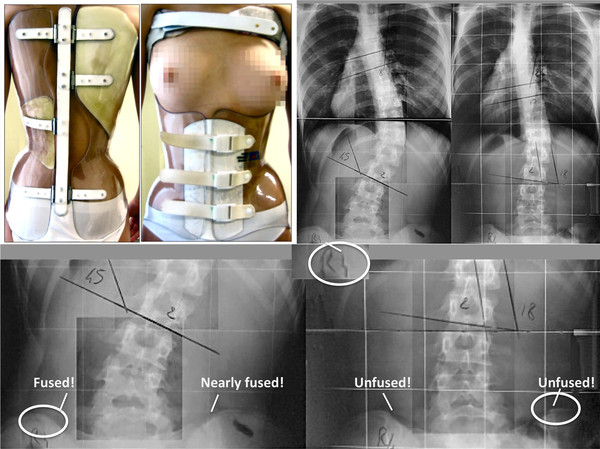
A sample of figures demonstrating that also in bracing it is not uncommon to treat mature individuals. The female patient on the upper left clearly is mature (Breast staging: Tanner 5). The x-rays as published within the same figure together with the clinical picture [26] on the first glance seem to show a drastical improvement of the curve as claimed by the authors. First of all, a permanent result like this cannot be achieved in a mature patient and is therefore not credible (on the left side x-ray a Risser 4 was estimated with fusion of the right iliac crest apophysis). Secondly, the Risser sign on the right x-ray seems more immature when compared to the left which could lead to the assumption that the right x-ray was the first and the left one was the last one and by this demonstrates a drastical curve progression. With kind permission of Pflaum, Munich (Weiss HR: Best practice in conservative scoliosis care. 4th edition in press).